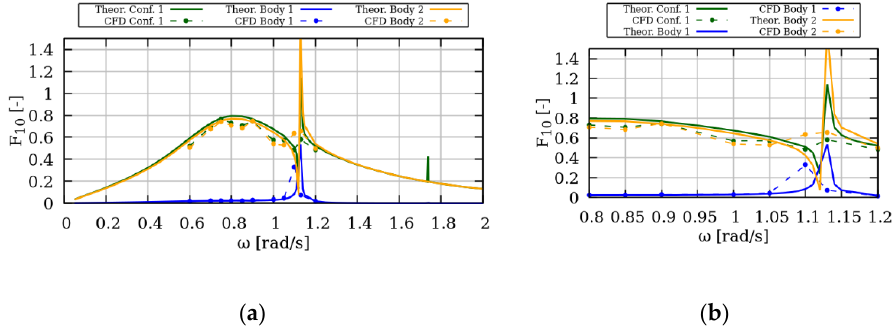
Figure 9. Comparison between the theoretical and CFD results of the non ‐ dimensional horizontal excitation force, in case of the Configuration 1; ( a ) wave frequencies between 0.05 and 2 rad/s; ( b ) wave frequencies between 0.8 and 1.2 rad/s (detailed view).